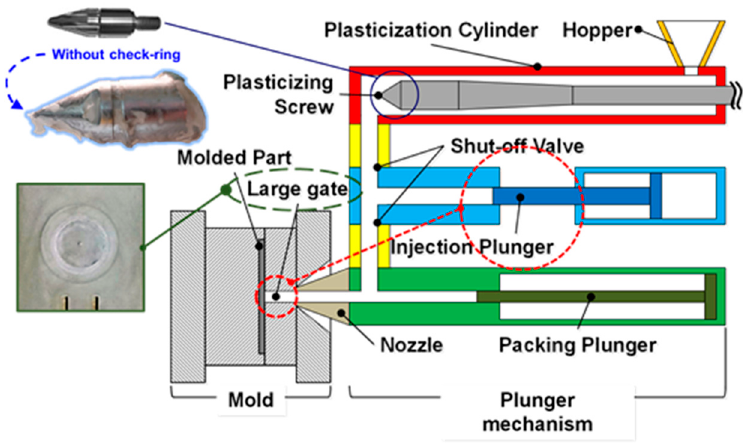
Figure 2. Design and application of the injection molding machine using a three-barrel injection mechanism (plasticization stage, filling stage, and packing stage).